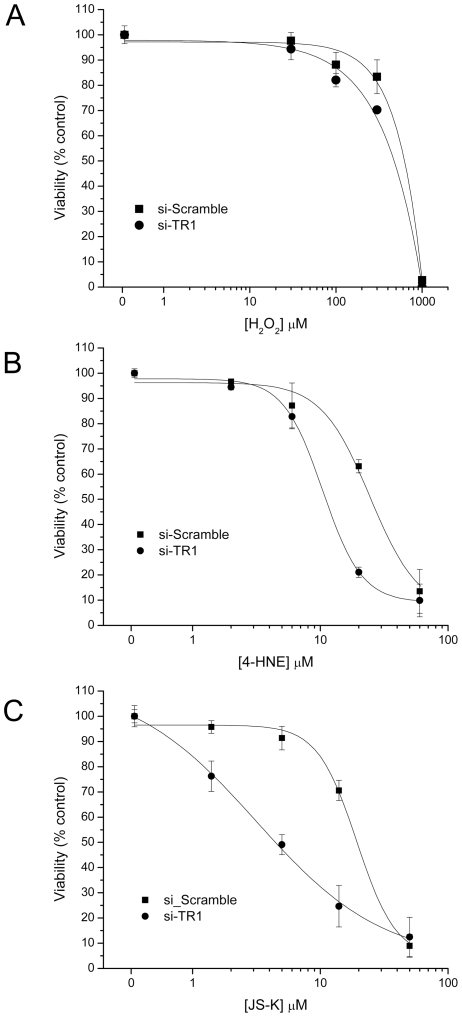
MTT-based viability assays for RKO cells following increasing concentrations of redox modulators.Cells with endogenous TR1 (si-Scramble, filled square), and cells with TR1 knocked-down by siRNA (si-TR1, filled circle) were compared at equivalent doses of the redox modulators. A) RKO cells were treated with increasing concentrations of H2O2 and the viability was measured after a 24 hrs exposure. No significant differences were observed. B) RKO cells were treated with increasing concentrations of 4-HNE and the viability was measured after a 24 hrs exposure. The si-TR1 cells displayed ∼2-fold increased sensitivity to 4-HNE. C) RKO cells were treated with increasing concentrations of JS-K and the viability was measured after a 24 hrs exposure. The si-TR1 cells displayed ∼6-fold increased sensitivity to JS-K.